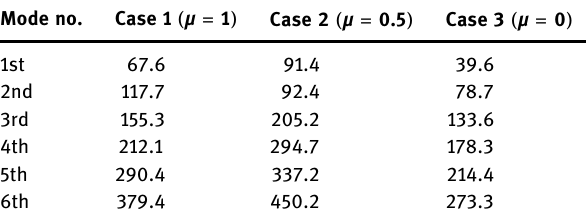
Table 3: Natural frequencies of di ff erent shear - web cases